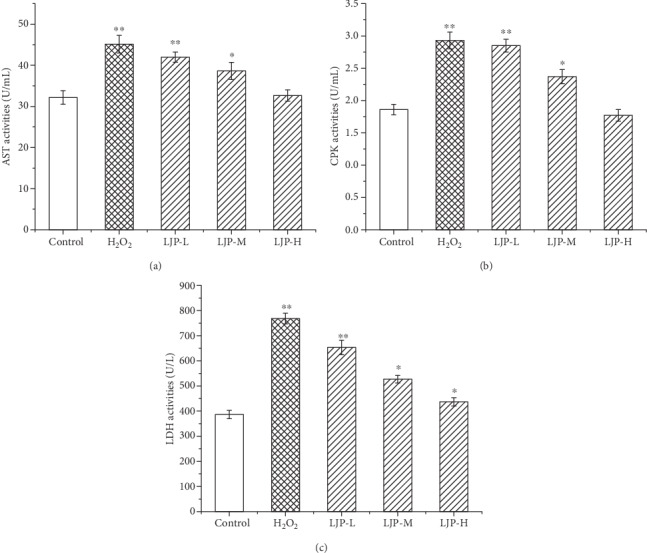
Effect of LJP on the AST, CPK, and LDH activities in cardiomyocytes cultured supernatant. (a) AST activity, (b) CPK activity, (c) LDH activity. Cardiomyocytes were incubated with different concentrations of LJP (10, 20, and 40 μg mL−1) for 12 h. Control group was added 100 μL DMEM medium. H2O2 model group was added H2O2 (200 μmol L-1) 100 μL. Then, the AST, CPK, and LDH activities in cultured supernatant were measured. The results are expressed as mean ± SD (n = 10). Statistical significance was determined by One-Way Analysis (ANOVA). ∗P < 0.05, ∗∗P < 0.01 versus control groups.